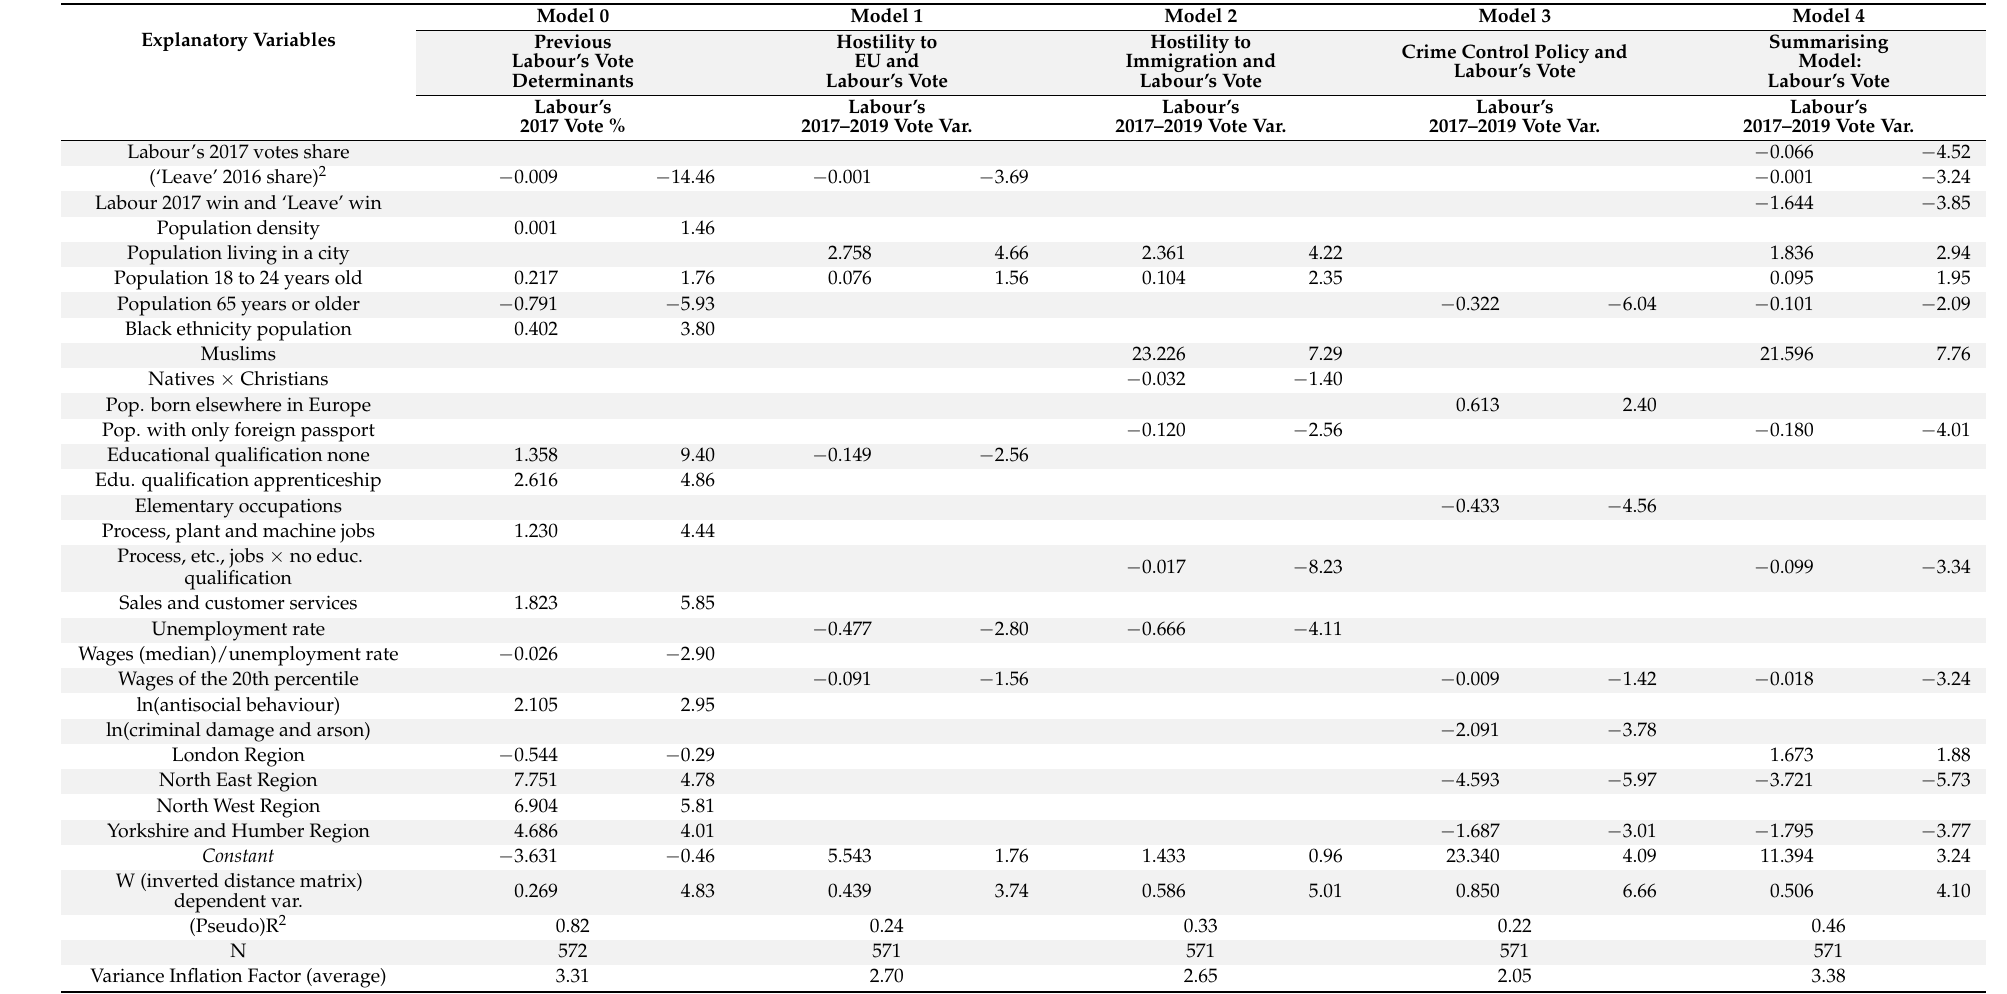
Table 1. Generalised spatial two-stage least squares regression models of statistical determinants of Labour’s 2017 vote and 2017–2019 vote variation by England and Wales’ constituency: coefficients and ‘t’